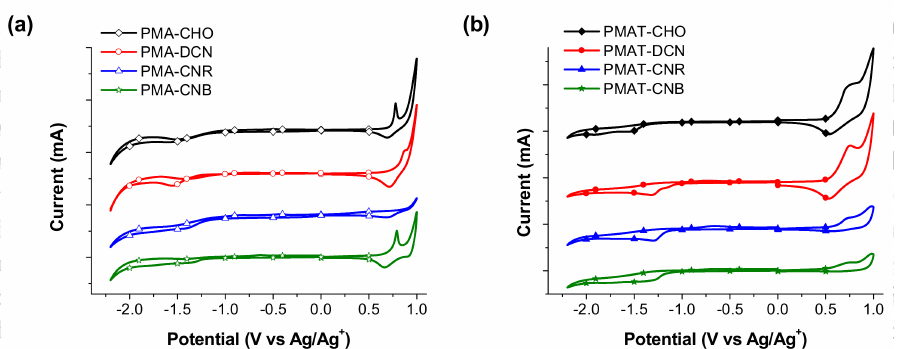
Figure 3. Cyclic voltammograms of copolymer films in Bu 4 NClO 4 solution (0.1 M in MeCN) for ( a ) PMA-CHO, PMA-DCN, PMA-CNR and PMA-CNB; ( b ) PMAT-CHO, PMAT-DCN, PMAT-CNR and